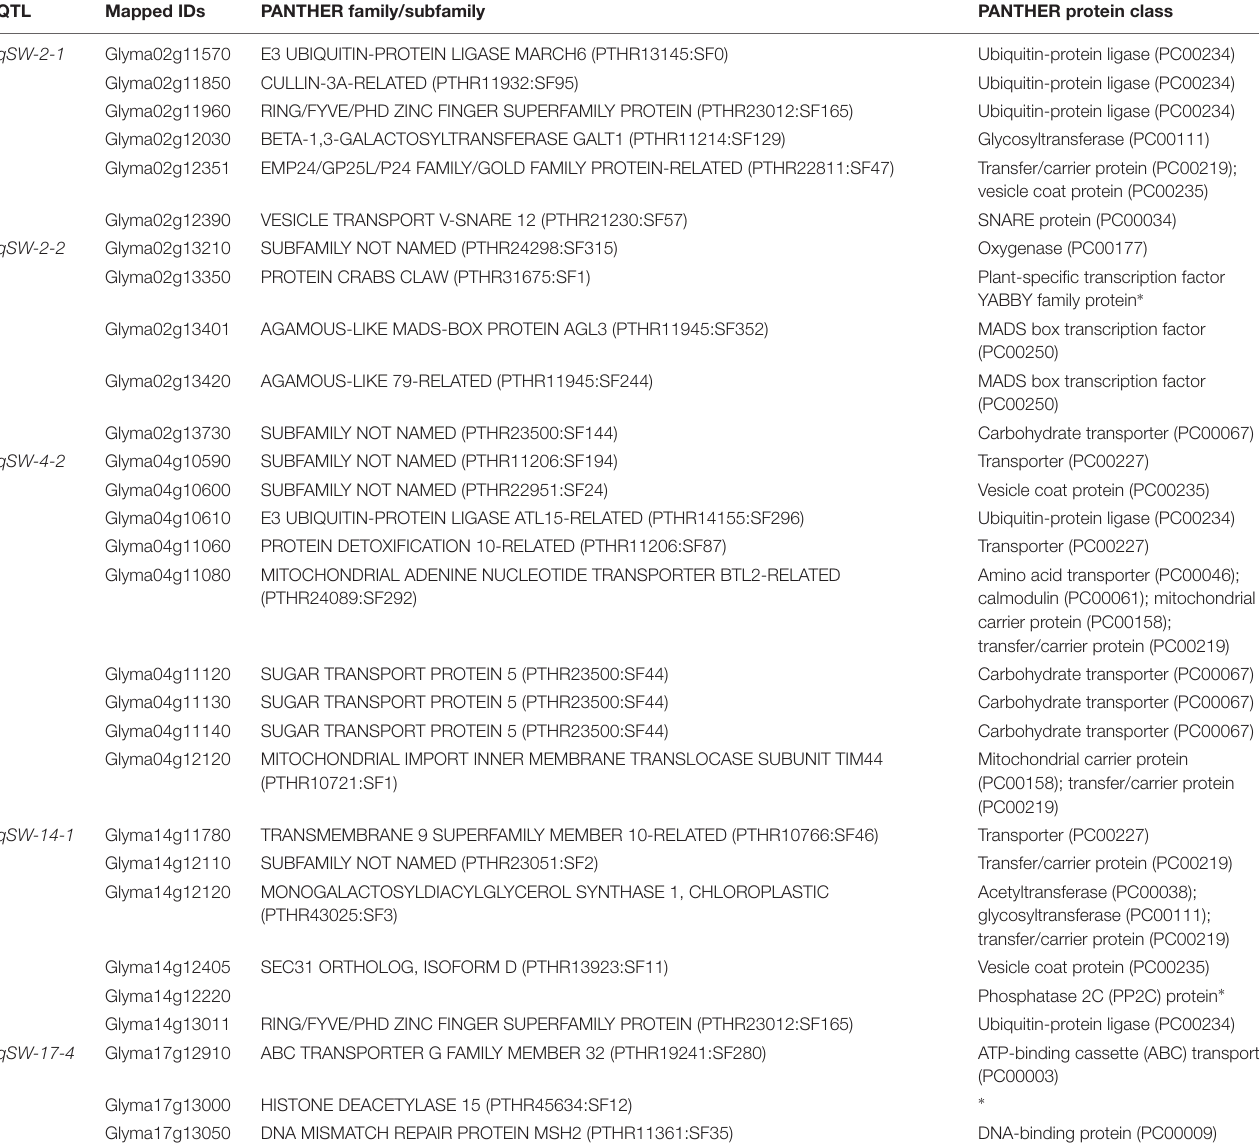
DNA MISMATCH REPAIR PROTEIN MSH2 (PTHR11361:SF35) DNA-binding protein (PC00009) Protein with ∗ indicates these proteins are selected from literature